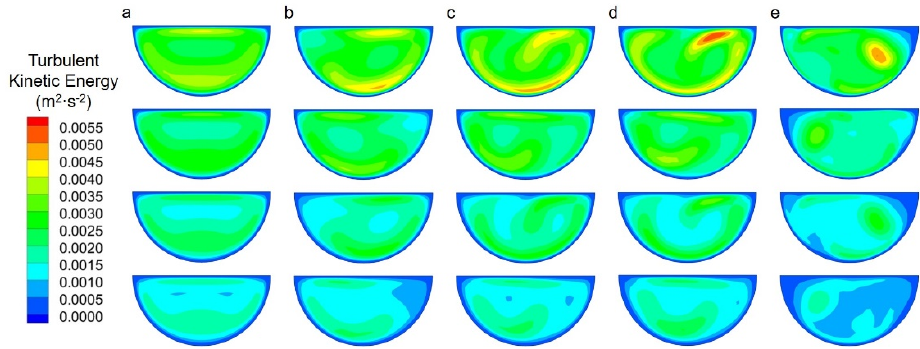
Figure 9. Turbulent kinetic energy contour of methane along flow direction in ( a ) Straight channel, ( b ) Zigzag channel, ( c ) Fillet channel, ( d ) Sinusoidal channel, ( e ) Trapezoidal channel. The Q criterion ( Q = 10,000) was adopted to obtain the vortex structure of the hot fluid among different channels in the range of z = 92.25 to 178.35 mm (Figure 10). In all the wavy channels, the vortex intensity is larger at corners, which increases the local pressure drop gradient and local heat transfer performance at these locations. Part of the strong vortex vanishes as the flow develops at non-corners; therefore, the friction loss is reduced, and the heat transfer enhancement is weakened. The vortex in the trapezoidal channel is strongest, which is consistent with the results shown in Figure 7 and Figure 8.